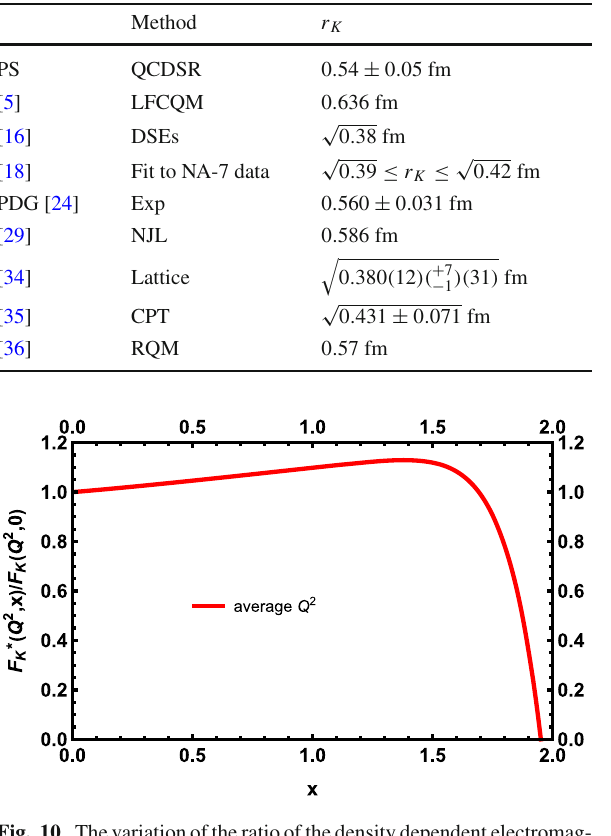
Fig. 12 Variation of the charge radius of the kaon with respect to the density of the medium